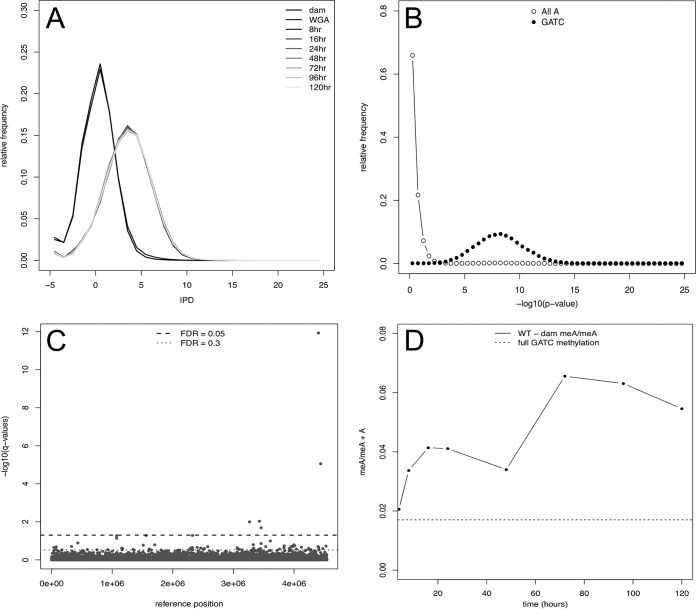
Virtually all GATC sites are methylated across time points. (A) The distribution of IPDs for each time point (8, 16, 24, 48, 72, 96, and 120 h) and negative-control samples (dam mutant strain and whole genome amplified [WGA]). The two distributions centered at 0 (black lines) are the negative controls (dam and WGA), while the light gray lines represent the time points. (B) A representative figure of the distribution of P values from a t test comparing the 8-h time point with the dam negative control. Open circles show the –log10 P values of adenines that are not located within a GATC site. Closed circles are the –log10
P values of adenines located within a GATC site. Panel B shows a representative time point, but every time point assessed is nearly identical (data not shown). (C) q values of a one-way ANOVA to determine significant temporal changes of IPD distributions. The dashed line represents an FDR of <0.05, while the dotted line and above represent an FDR of <0.3. (D) Liquid chromatography-mass spectroscopy (LC-MS) detection of methylated adenine over 5 days of incubation in LB. The black line represents the fraction of methylated adenine (meA) over total adenine over 5 days, performed in triplicate with biological duplicates. Since the LC-MS method cannot distinguish between methylated adenines located within GATC sites versus the total chromosome, levels of meA/total A may surpass expected levels due to nonspecific methylation by Dam, which has been reported previously to occur at 5′-GACC-3′, 5′-HATC-3′ (H = A, T, or C), and 5′-GATT-3′ sequences (56). Propagated error across samples (two biological samples with two replicates) was 6.8% (8 h), 13.8% (16 h), 14.7% (24 h), 5.9% (48 h), 43.9% (72 h), 5.8% (96 h), and 27.9% (120 h).